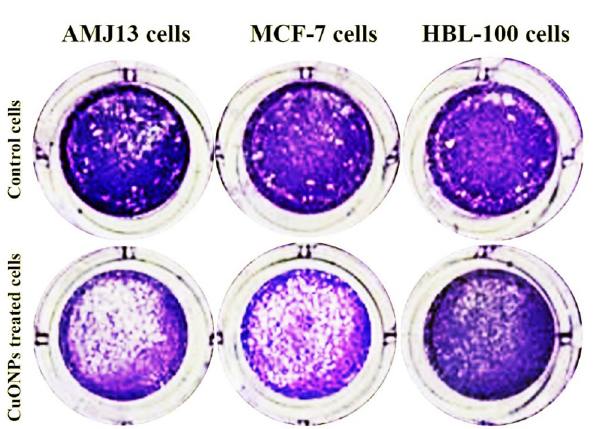
Figure 4. The Antiproliferative activity of CuO NPs against cancer cell lines. Triplicate samples of AMJ-13, MCF-7, and HBL-100 cells at a concentration of 1 × 10 4 cells mL −1 were seeded. CuO NPs were added to these samples and incubation periods for 72 h. Cells were stained with MTT. The 492 nm wavelength was selected to assess absorbance.